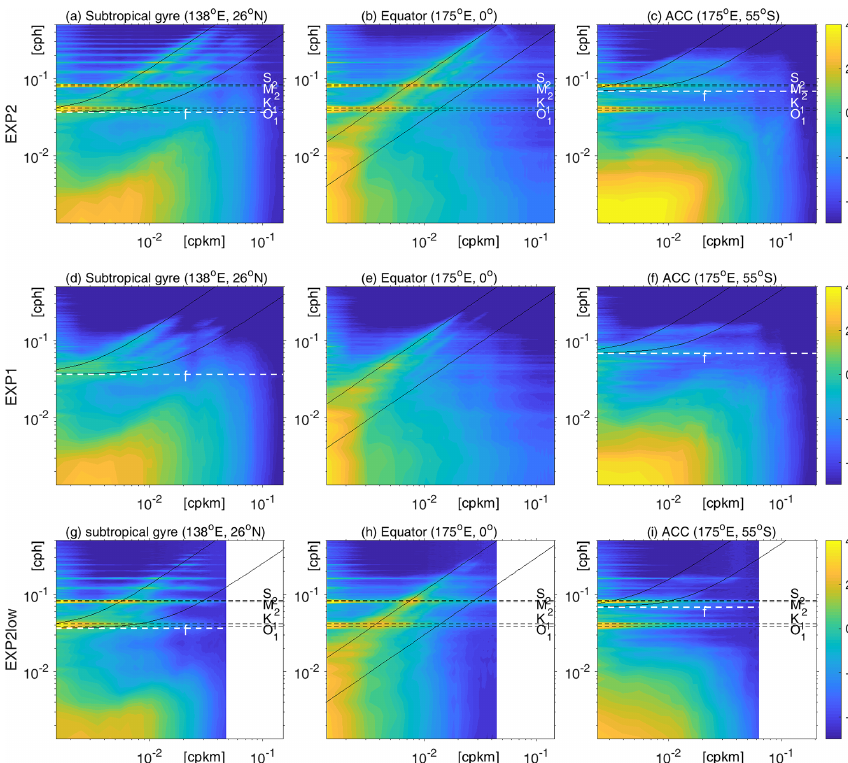
Figure 15. SSH variance spectrum amplitude [m 2 (cpkm × cph) − 1 ] in horizontal wavenumber–frequency space estimated from 10 ◦ × 10 ◦ boxes centred at 26 ◦ N, 138 ◦ E (a, d, g) , 0 ◦ N/S, 175 ◦ E (b, e, h) , and 55 ◦ S, 175 ◦ E (c, f, i) . The upper and middle panels are based on hourly outputs of EXP2 and EXP1, respectively, and the lower panels are based on the 1 / 10 ◦ EXP2Low outputs. Dashed white lines denote the inertial frequencies, and dashed black lines denote the tidal constituents of S 2 , M 2 , K 1 , and O 1 . Solid black curves denote the dispersion relations for inertia-gravity waves of the 1st (upper) and 10th (lower) vertical modes. Note that the colour scale is